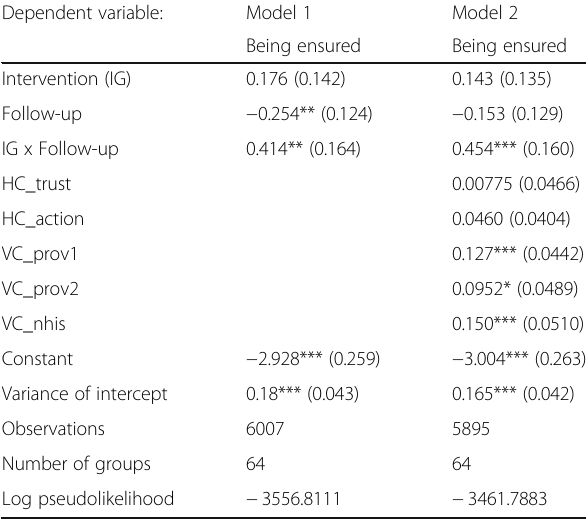
Table 2 The effect of the intervention on insurance enrolment and the relationship between social capital and